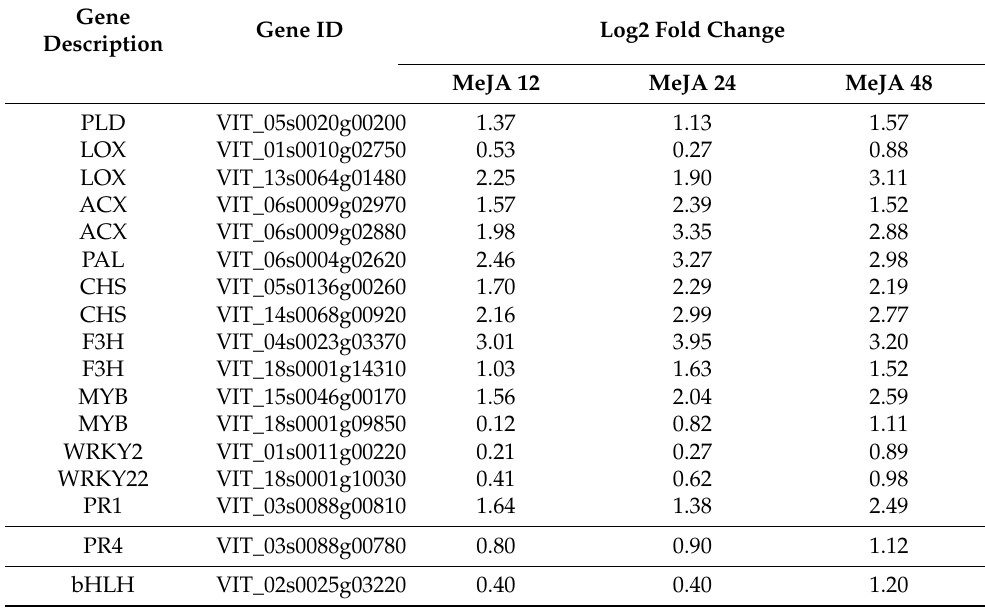
Table 3. DEGs involved in defense response to MeJA at different time points and transcription factors in DEGs with-fold